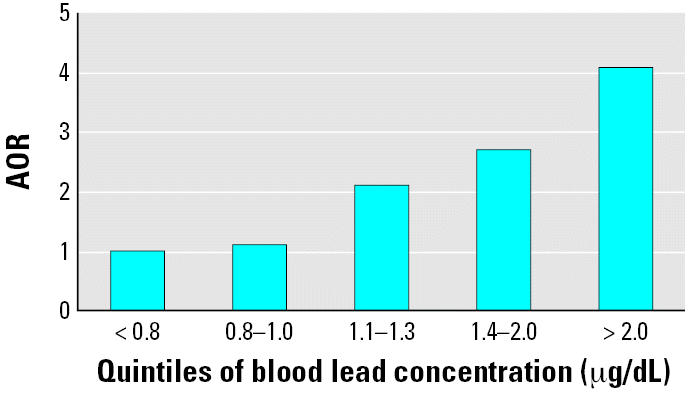
AOR for ADHD among U.S. children, NHANES 1999–2002, by blood lead concentration (μg/dL). The model was adjusted for child’s age, sex, race/ethnicity, preschool attendance, serum ferritin, prenatal ETS exposure, smoker in the household, and insurance status.p-value for trend = 0.012.